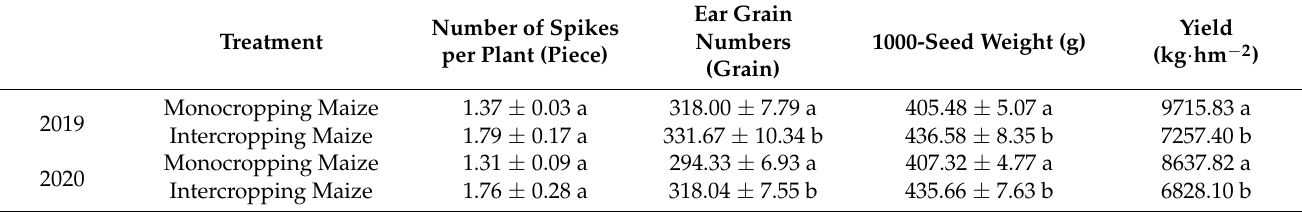
Table 3. Monocropping and intercropping maize yield and yield components in 2019 and